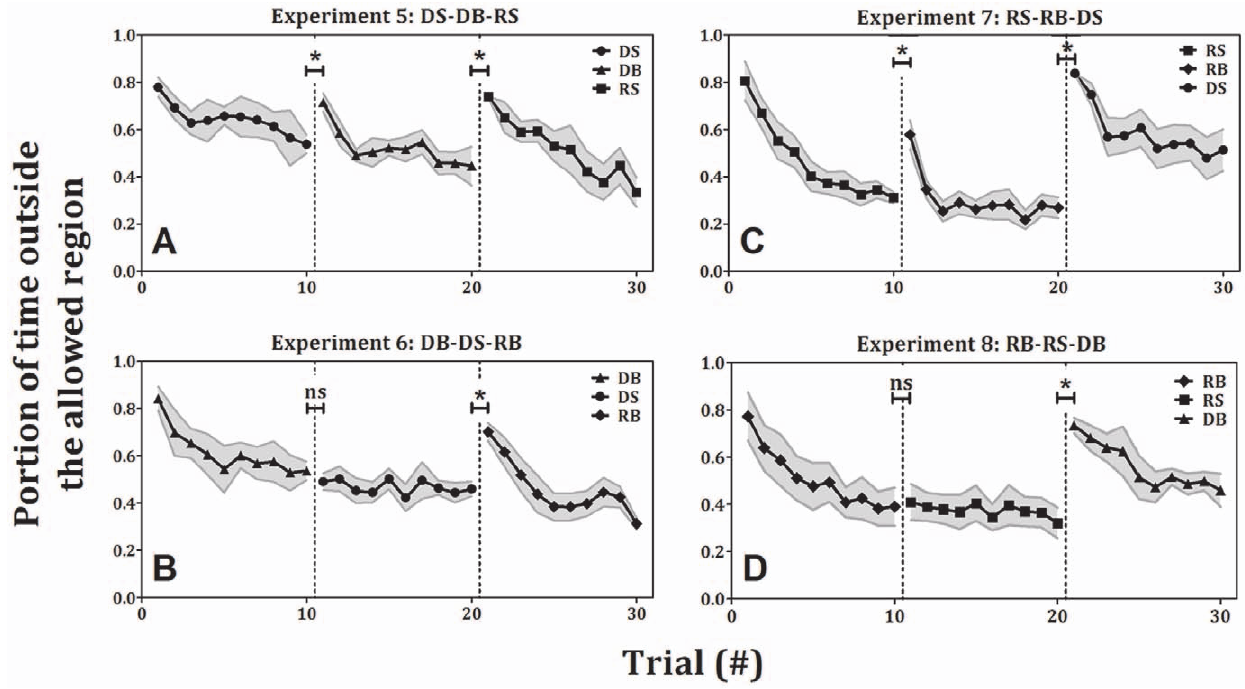
Figure 7. Error as a function of trial number for experiments 5–8 ( ± standard error). Each shape represents a different condition of the task: circles – discrete small, triangles – discrete big, rectangles – rhythmic small, diamonds – rhythmic big. In the transition from small movements to big movements (panels A and C, first transition), there is a significant increase in error. In the transition from big movements to small movements (panels B and D, first transition), there is no significant change in error. In the transition from discrete movements to rhythmic ones (panels A and B, second transition) and from rhythmic movements to discrete ones (panels C and D, second transition), there is a significant increase in error. trial of the first block (0.54 6 0.04 and 0.39 6 0.08, mean 6 SE for